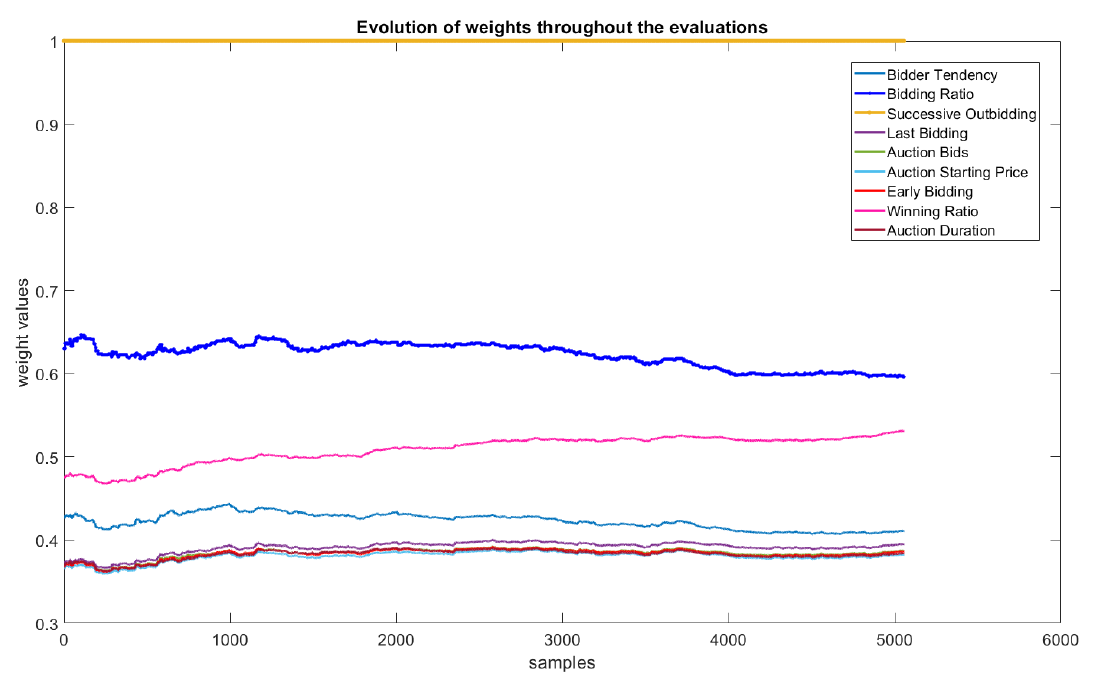
Figure 13. Feature separability criteria throughout the evaluations of the eFNN-SODA model.